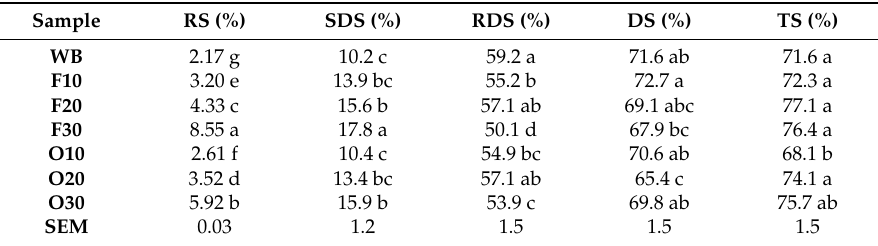
Table 3. Starch digestibility of bread samples (g / 100 g